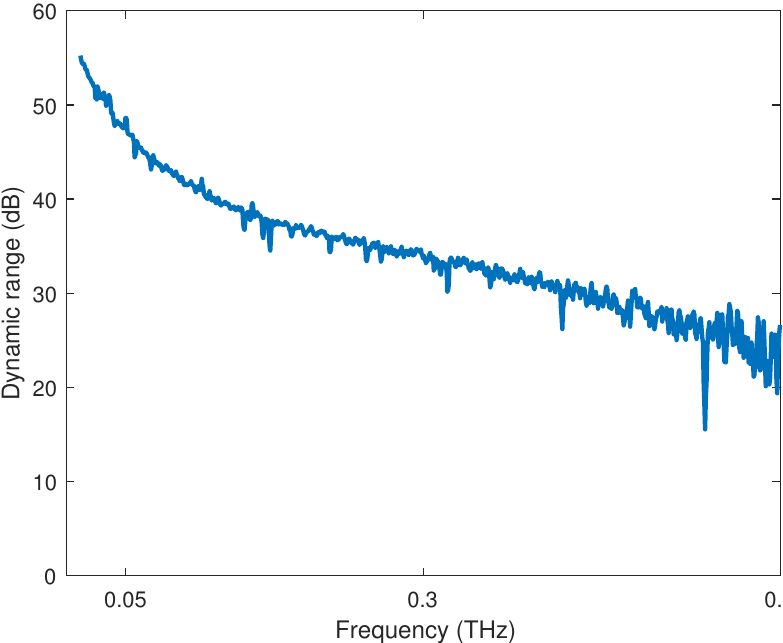
Figure 11. The spectral characteristic of the proposed QCW-THz system in the span of 0.1–0.6 THz with OSG resolution of 2